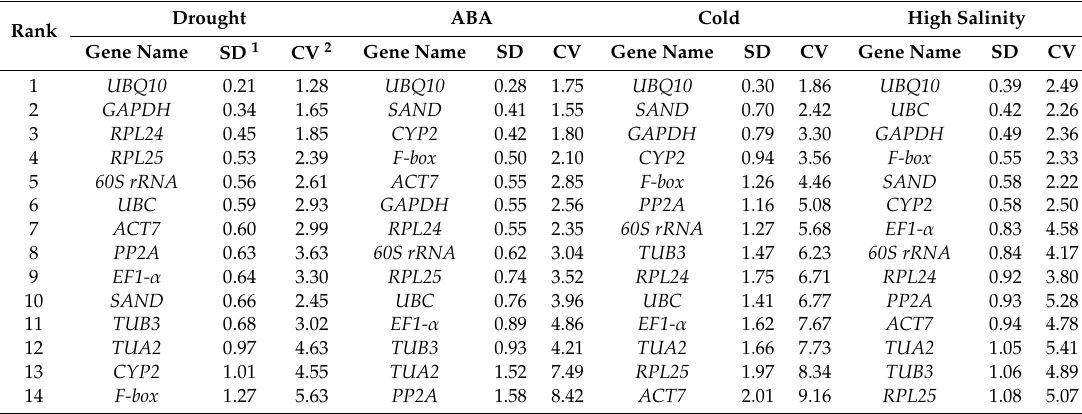
Table 4. Expression stability of candidate reference genes calculated by BestKeeper.